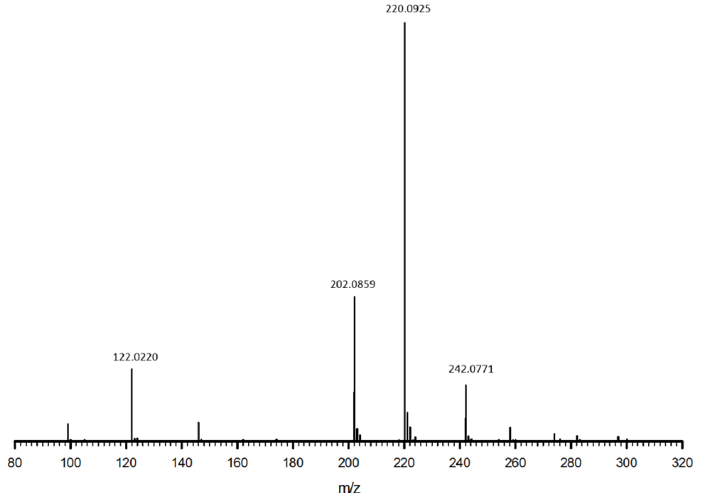
Figure 1. Mass spectrum of synthetic cysteine monoadduct 3 (cys-4MMP).